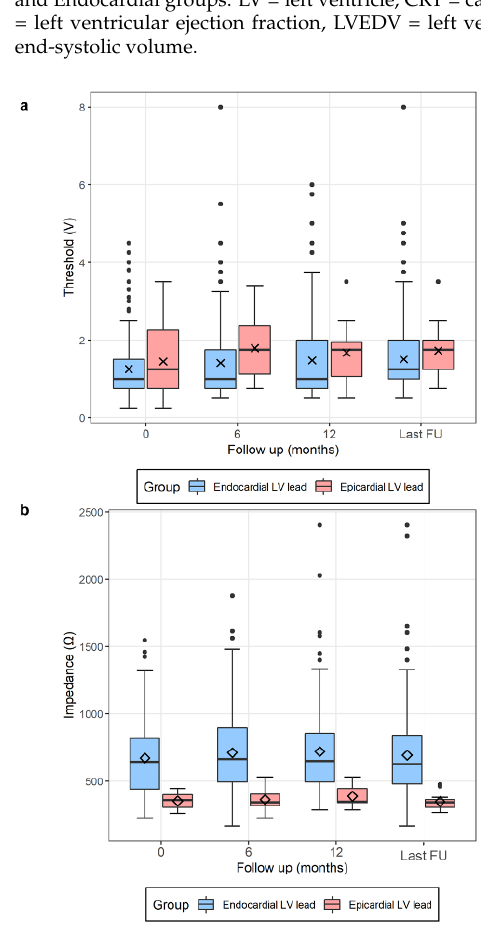
Figure 3. Serial changes in pacing threshold ( a ) and impedance ( b ) of epicardial and endocardia LV leads during the follow-up. LV = left ventricle.